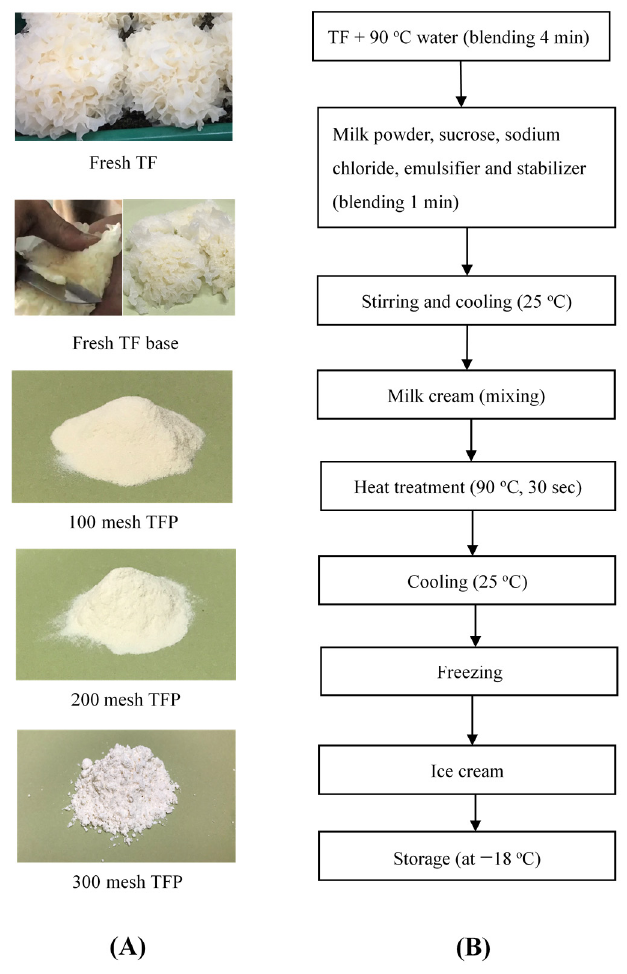
Figure 1. Tremella fuciformis sample ( A ) and ice cream production flow chart ( B ).